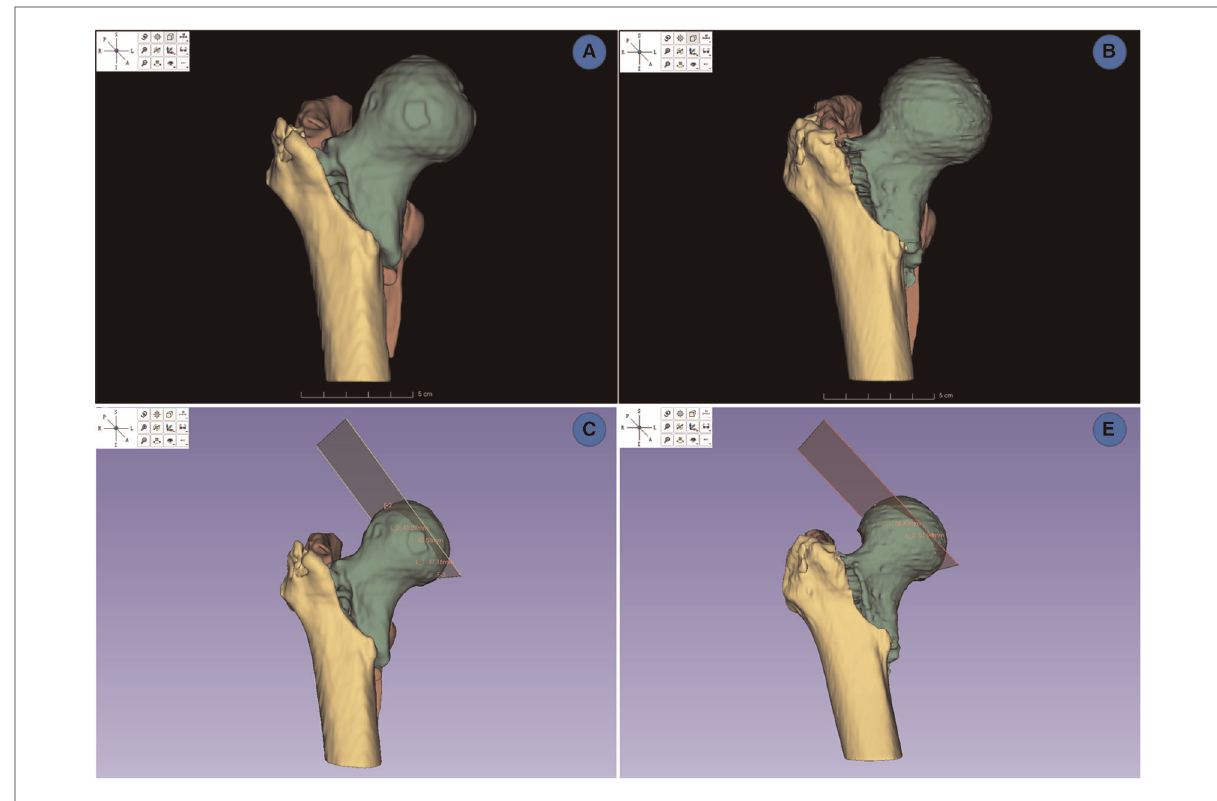
FIGURE 6 3d reconstruction and measurements of FHDs on slicer. ( A,B ) 3D rendering from manually segmented masks and automatically segmented masks. ( C,D ) measurement of FHD on 3D model from manually segmented masks and automatically segmented masks.